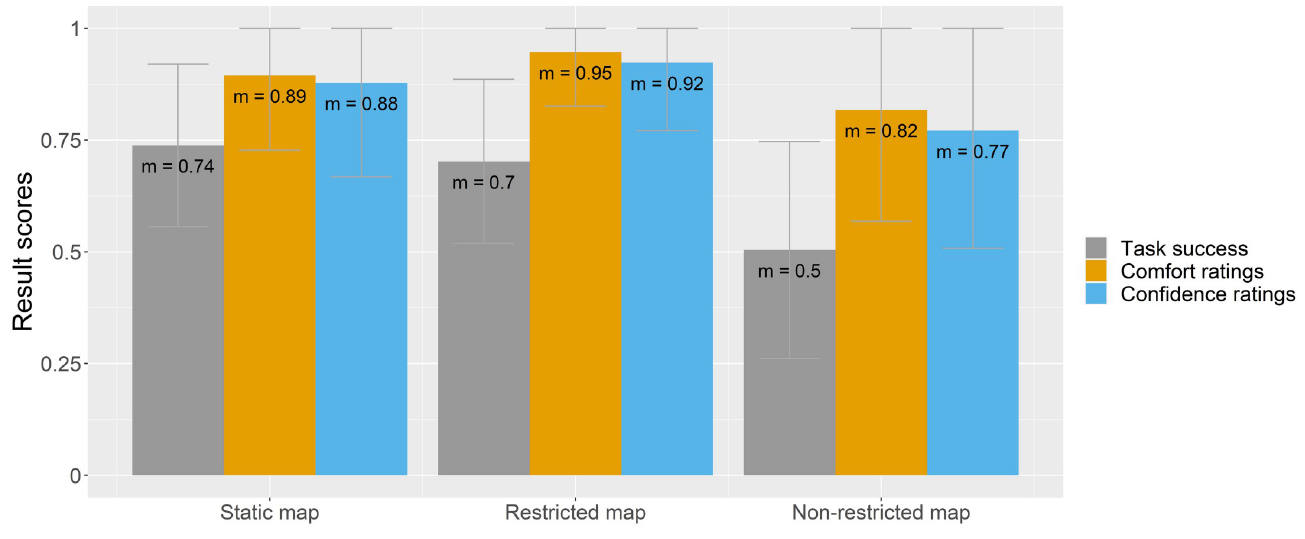
Fig 8. Task success, comfort, and confidence ratings by interactivity